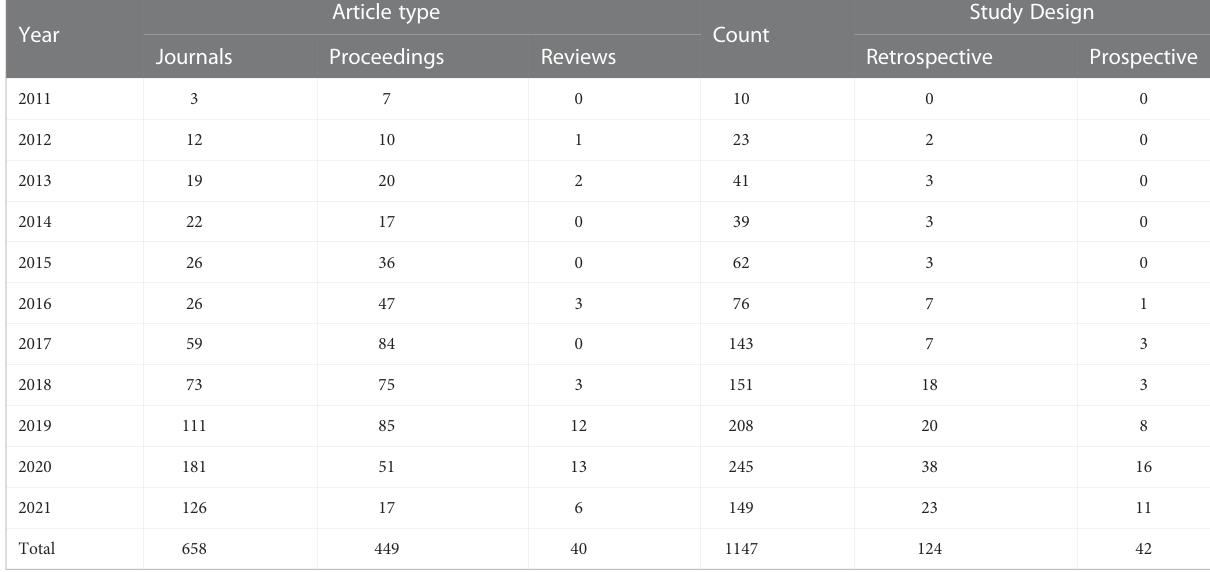
TABLE 2 The yearly publication count.